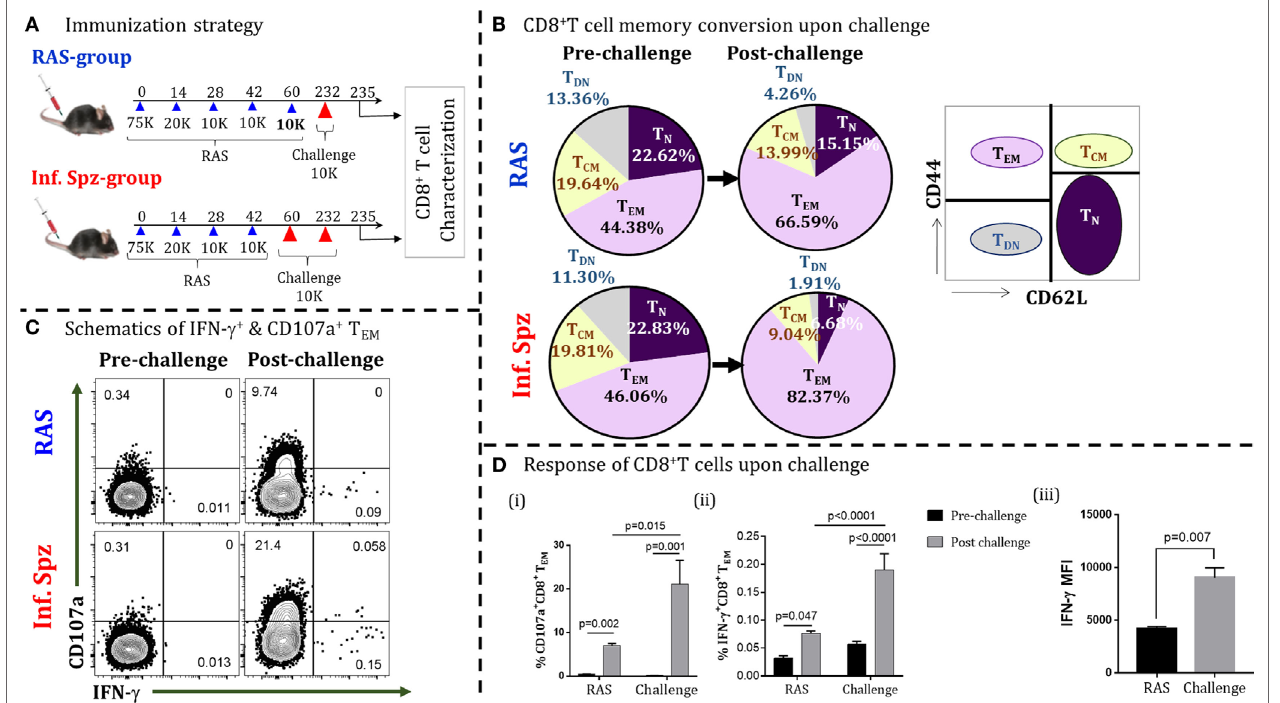
FigUre 1 | Infectious sporozoites (Inf. Spz) challenge induces qualitatively different liver-stage specific CD8 + T cells in radiation-attenuated sporozoites (RAS) immunized mice. (a) Immunization strategy. C57BL/6 mice were immunized with RAS (70K-20K-10K-10K) intravenously at biweekly interval. Some of the RAS immune mice were challenged with 10K Inf. Spz on 2–3 weeks post last-boost immunization (Inf. Spz group) while others were challenged with 10K RAS in place of Inf. Spz (RAS group). Mice from both groups were challenged on day 232 for the reactivation of liver-stage specific memory CD8 + T cells. The T cells were characterized on day 3 post-challenge (Figure S1 in Supplementary Material). (B) Pie chart analysis of the CD8 + T-cell subsets in RAS- and Inf. Spz groups pre- and day 3 post-challenge: naïve (T N ) (CD44 − CD62L + ), central memory (T CM ) (CD44 + CD62L + ), effector memory (T EM ) (CD44 + CD62L − ), and double-negative (T DN ) (CD44 − CD62L − ) phenotypes. (c) Representing dot plots of IFN- γ + and CD107a + CD8 + T E/EM cells of RAS or Inf. Spz group (D) (i) % CD107a + , (ii) IFN- γ + CD8 + T E/EM cells, and (iii) The expression levels of IFN- γ in CD8 + T E/EM cells measured in terms of mean fluorescent intensity (MFI) day 3 post-challenge. N = 6 mice per group. Data are the mean ± SEM. The data were analyzed with non-parametric Mann–Whitney U -test. p < 0.05 is considered as a significant. Data shown represent one of two independent